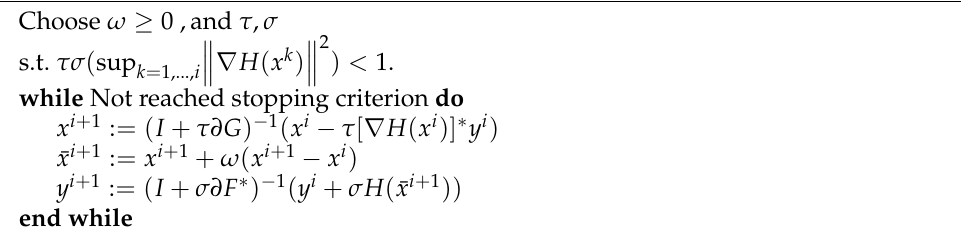
Algorithm 1 Non-linear primal-dual proximal splitting presented in [17] (Algorithm